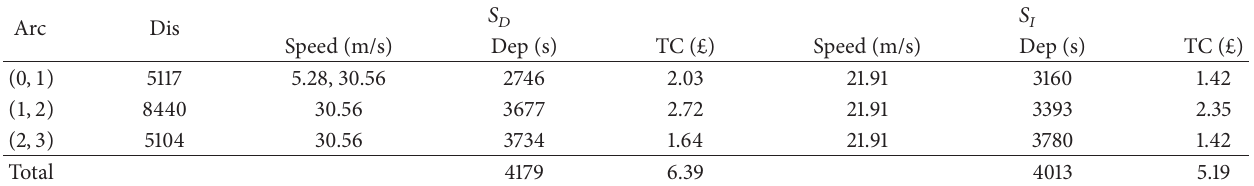
Table 3: Results in Example